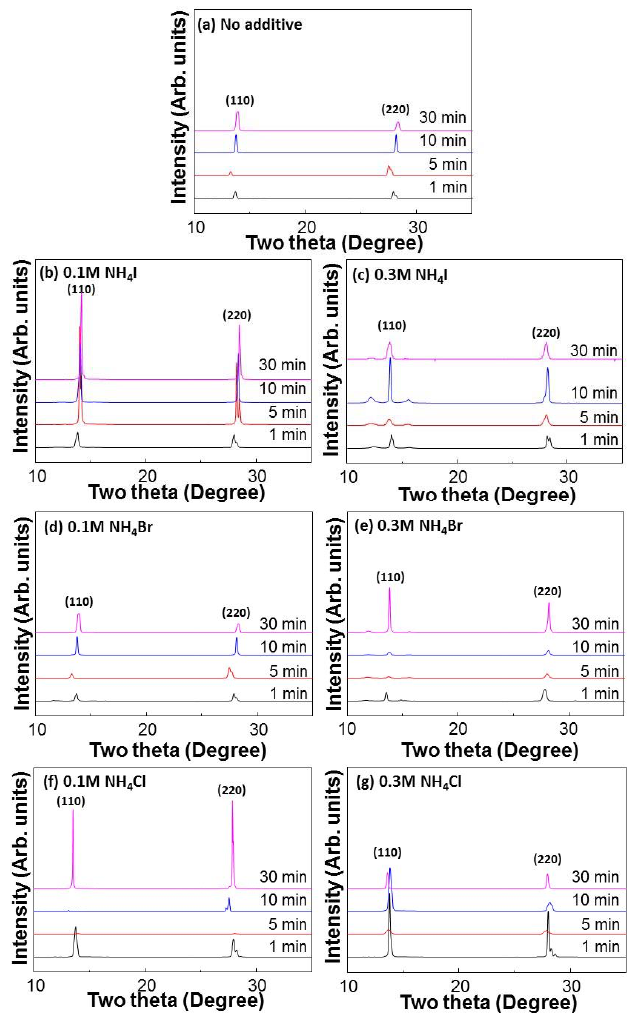
Figure 2. XRD spectra of CH 3 NH 3 PbI 3-x Cl x layers spin-coated on PEDOT:PSS layers. The CH 3 NH 3 PbI 3-x Cl x solutions used for spin-coating contained ( a ) no additive, ( b ) 0.1 M NH 4 I, ( c ) 0.3 M NH 4 I, ( d ) 0.1 M NH 4 Br ( e ) 0.3 M NH 4 Br ( f ) 0.1 M NH 4 Cl, and ( g ) 0.3 M NH 4 Cl respectively. The samples were annealed at 100 ◦ C for different times (1, 5, 10, 30